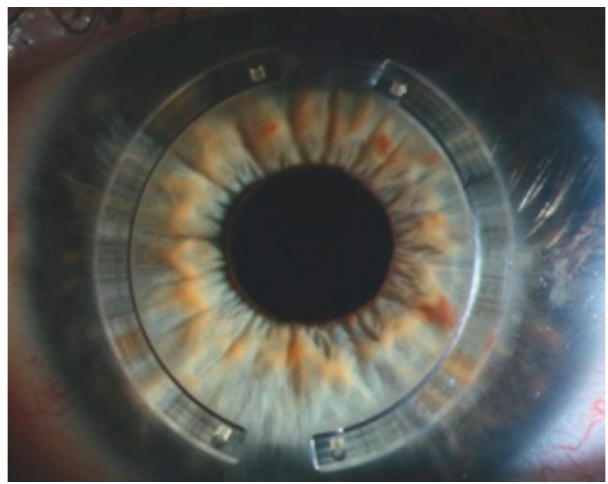
Figure 12. Intrastromal corneal ring segments implanted into fs-laser cut pockets.